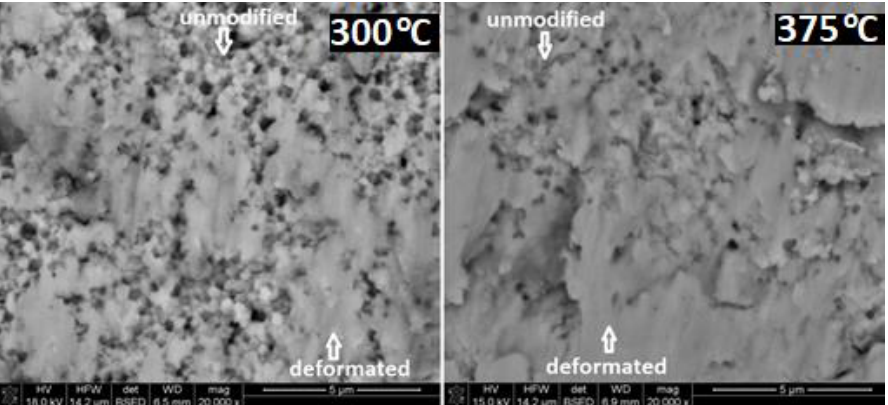
Figure 13. SEM images of the worn surfaces of the ATZ material after the ball-on-disc test performed at the different temperatures indicated in top right corners of the figures. All magnifications were the same. The marker bar indicates 5 microns.